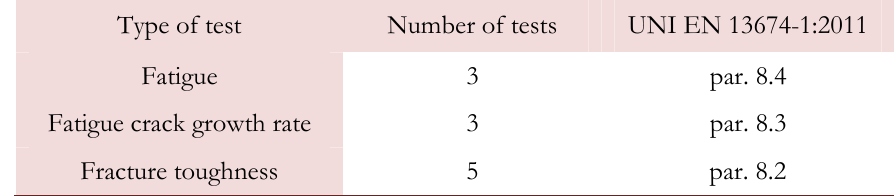
Table 1: Number of samples for each type of test and corresponding paragraph in the Standard.